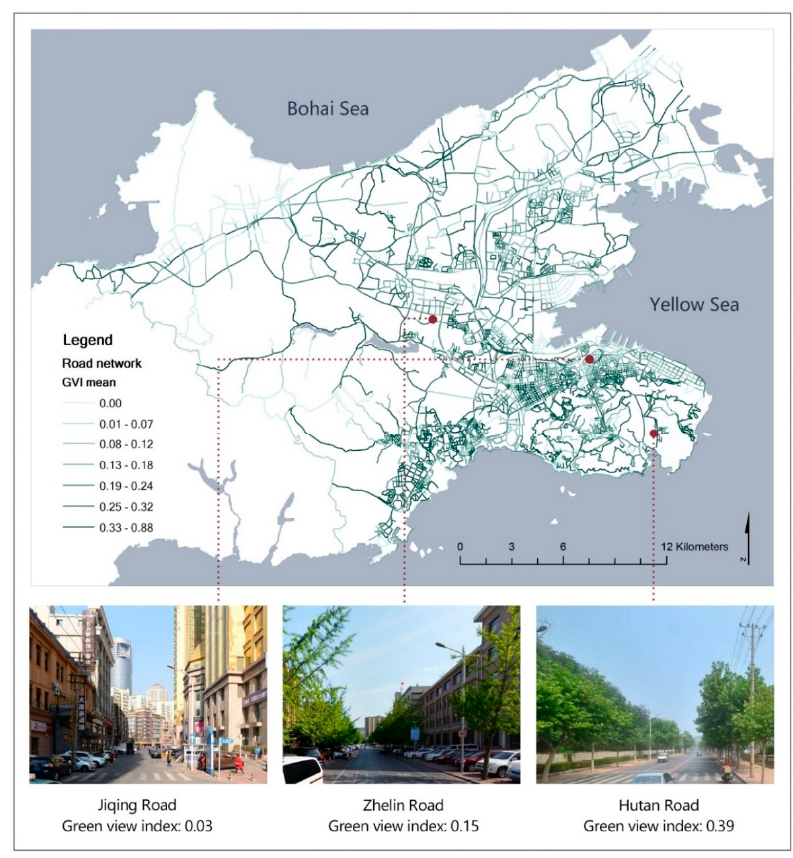
Figure 5. Tree identification for streetscape design.